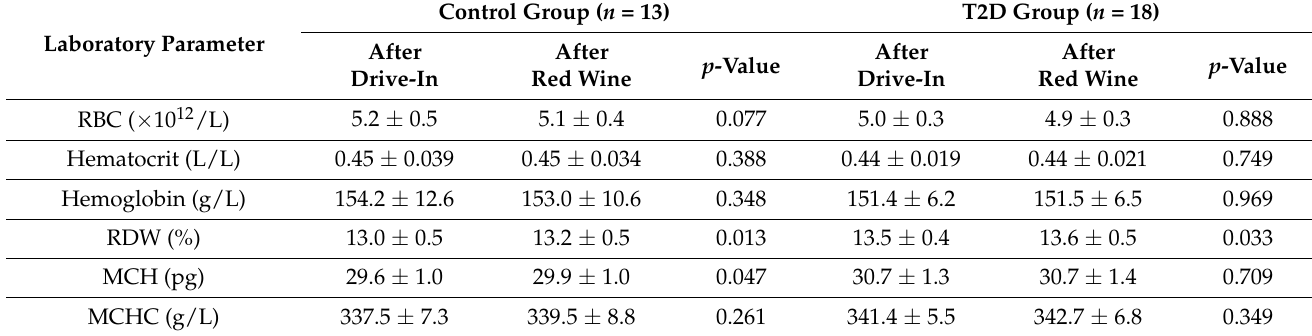
Table 2. Laboratory indicators of the iron status of participants with type 2 diabetes mellitus and control subjects and at pre- and